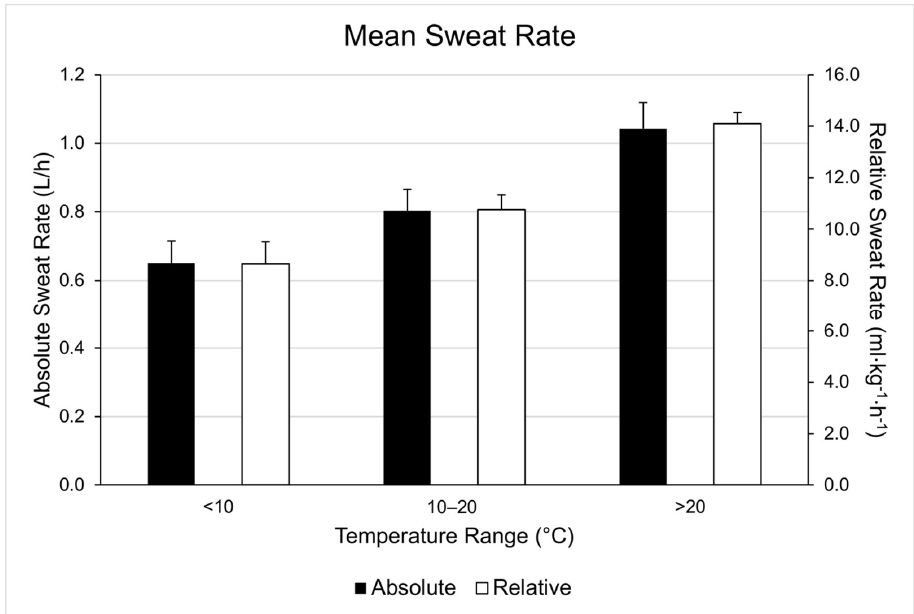
Figure 2. Mean sweat rates (L/h) for four participants that completed training sessions within each temperature range.